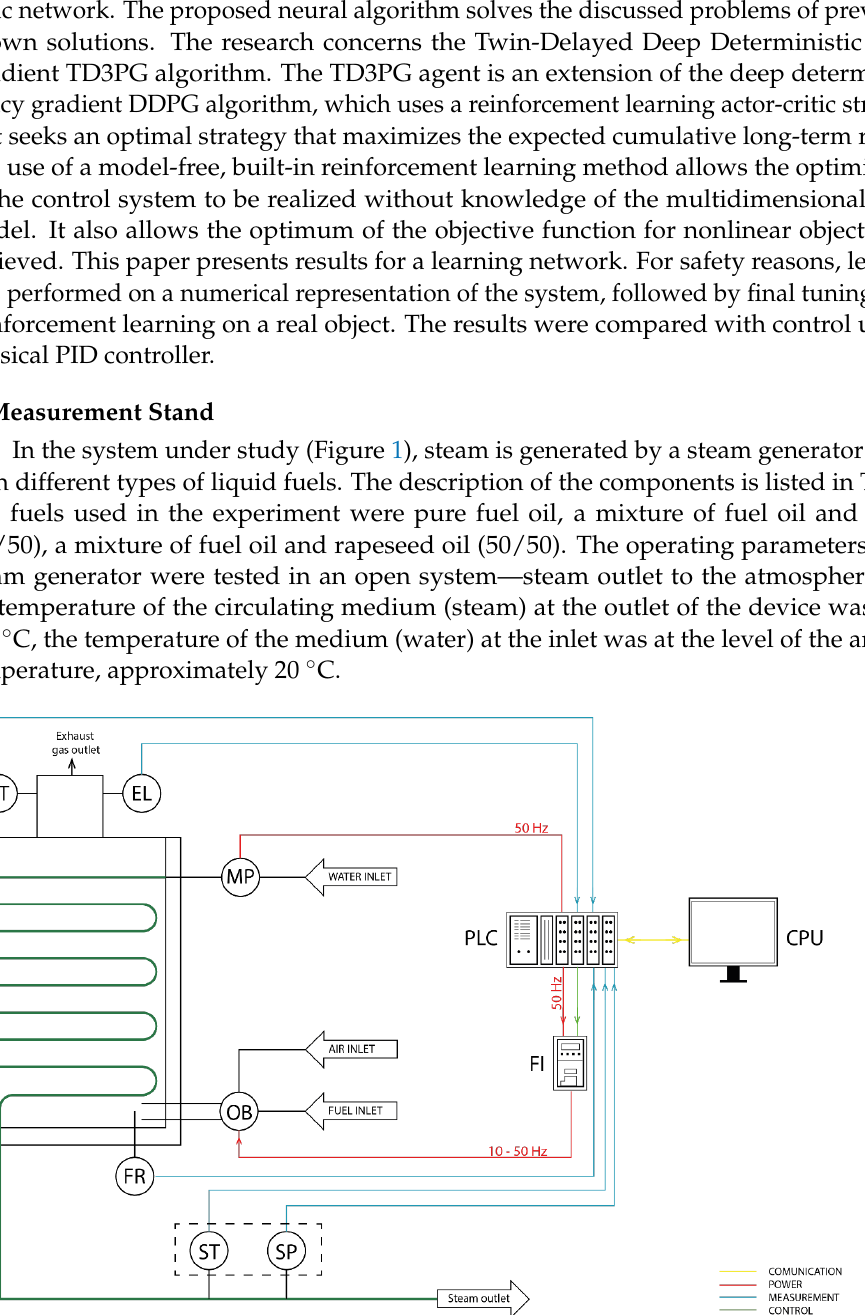
Figure 1. Schematic of a steam generator fueled with liquid fuel mixtures. The components of the steam generator test stand are described in Table